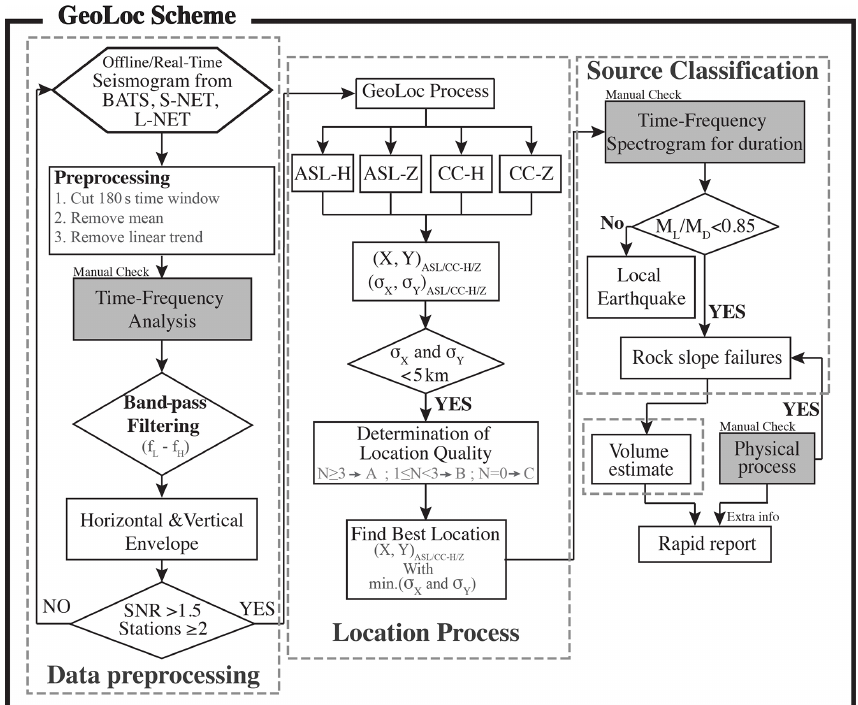
Figure 2. Flowchart of the GeoLoc scheme, including data preprocessing, location process, source classification, and volume estimation. All steps are automatic except the steps with gray shading, which involved a manual check in this research. f L and f H are the respective lower and upper band of the band-pass filtering. ( X,Y ) ASL/CC − H/Z is the best location from the ASL or CC with horizontal or vertical components. ( σX,σY ) ASL/CC − H/Z are those location uncertainties based on the relative fitness over 0.95. N is the number of results from methods with components (total: N = 4) whose location error is less than the 5km threshold. The result with the minimum location error defines the best